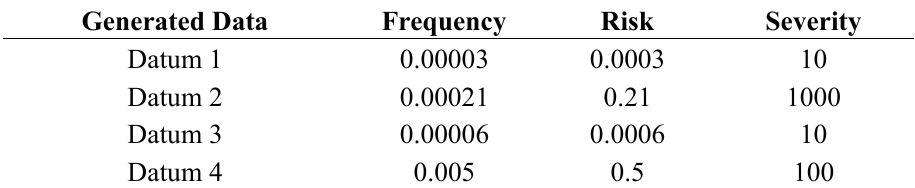
Table 3. Frequency and severity of generated